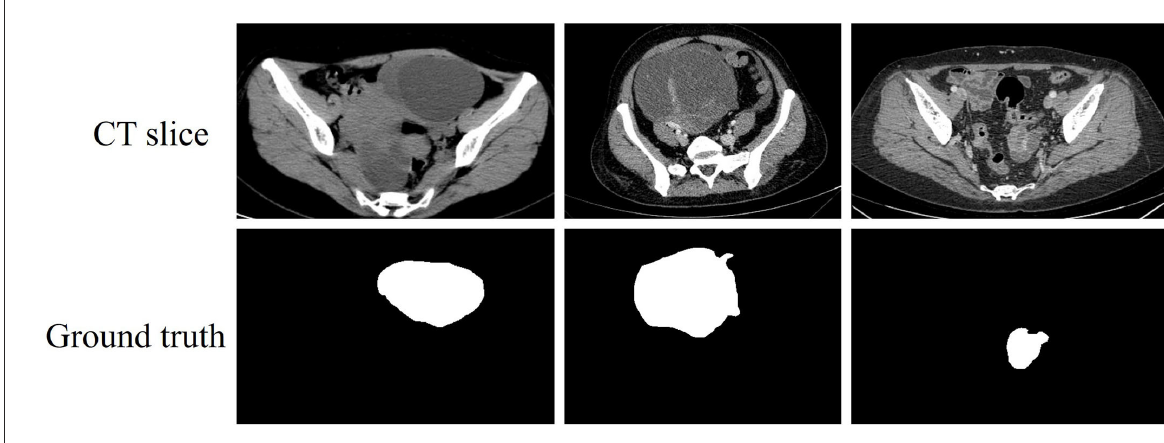
FIGURE1 CT slices of ovarian tumor and their corresponding ground truth.